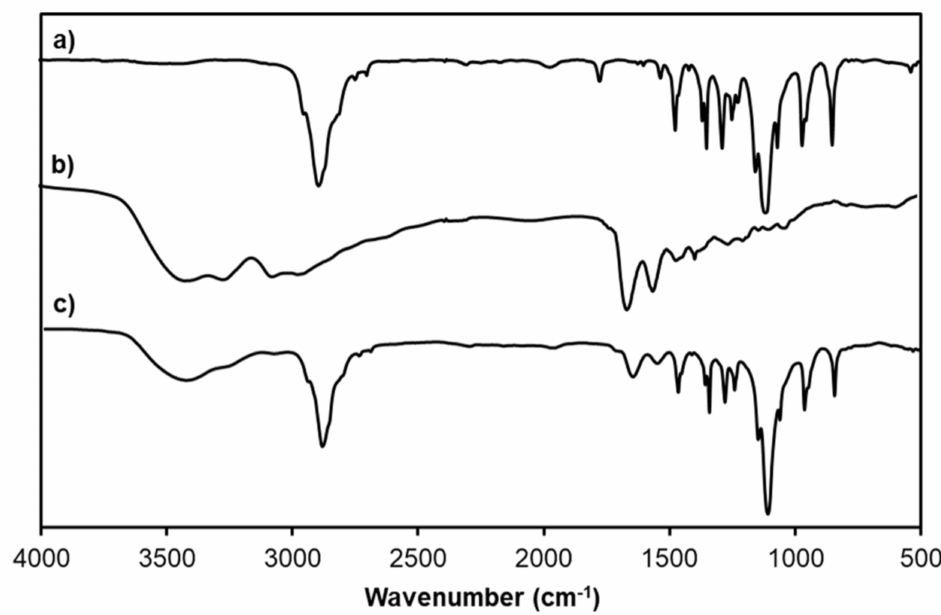
Figure 3. Fourier transform infrared spectroscopy (FT-IR) patterns of ( a ) mPEG-NPC, ( b ) PAMAM G3.0, and ( c ) PAMAM